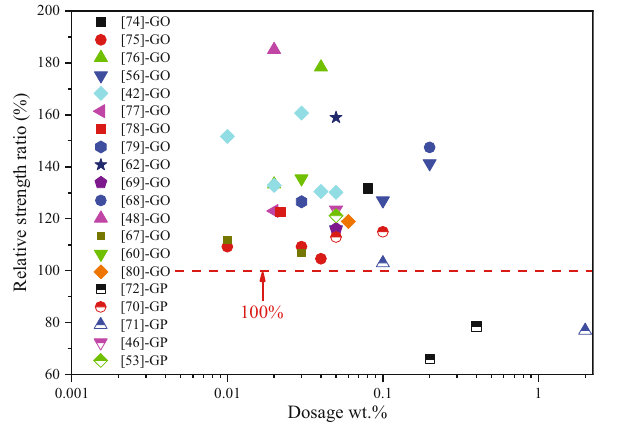
Figure 3: The e ff ect of dosages and the fl exural strength.